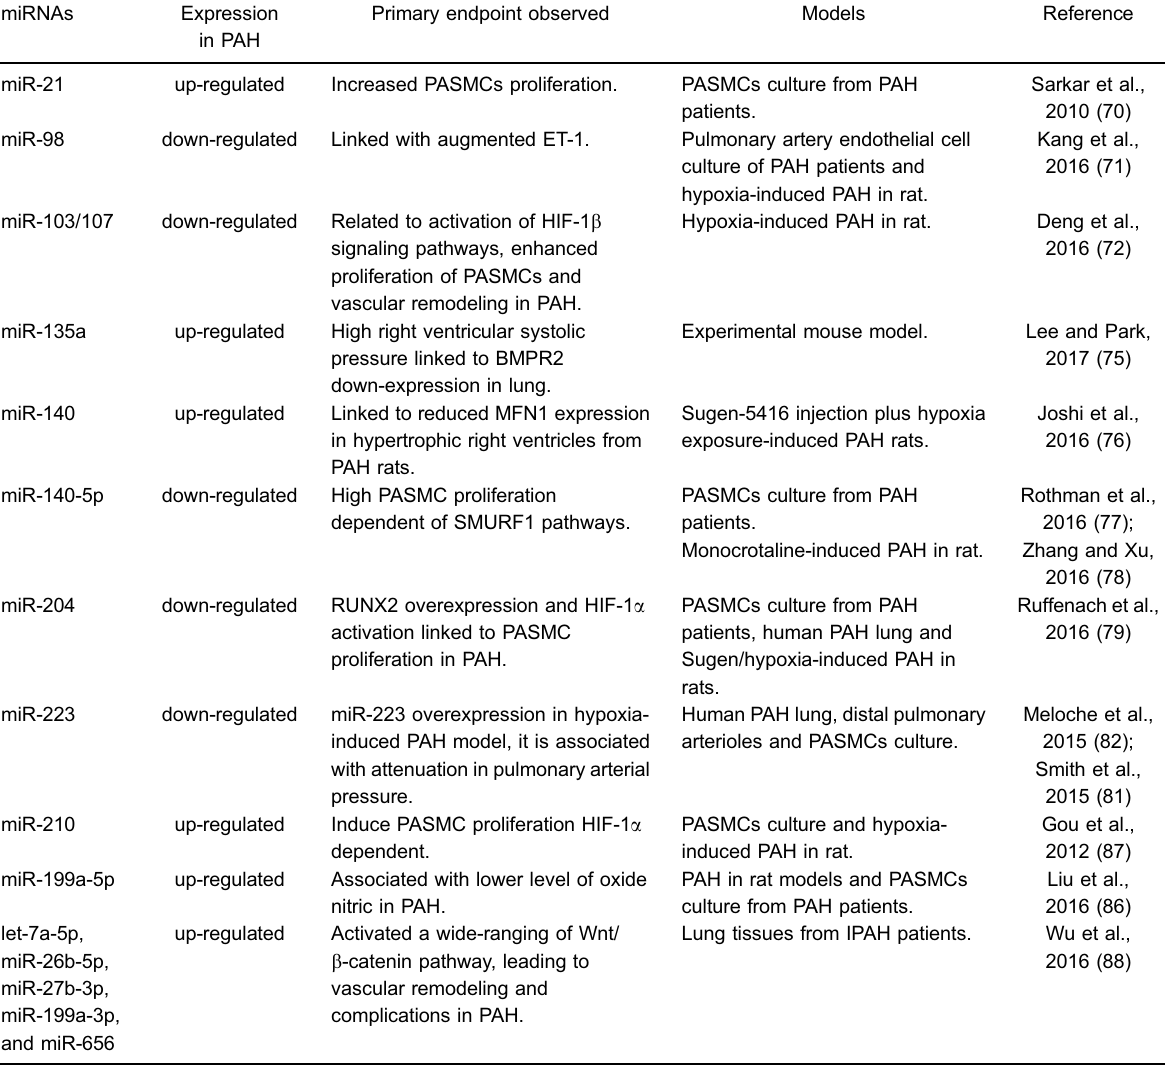
Table 1. Non-coding RNAs involved in pulmonary arterial hypertension (PAH) development.